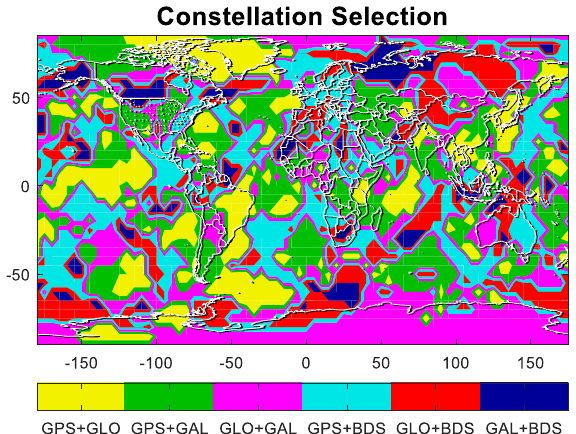
Figure 8. Worldwide distribution of constellation combination.